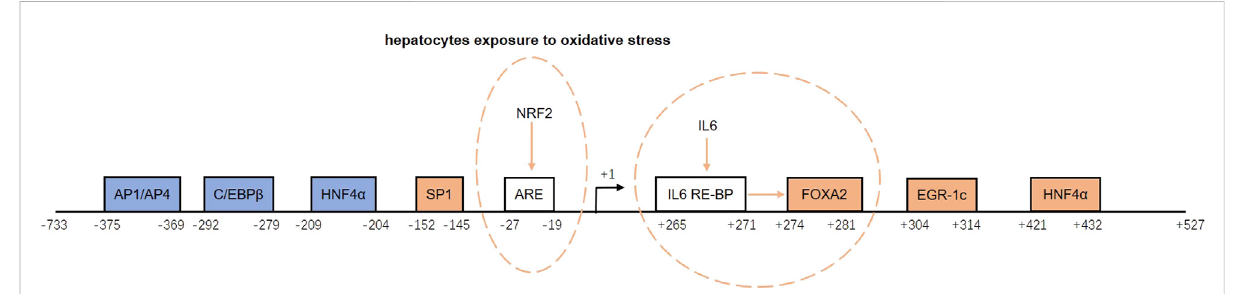
FIGURE 2 Structure and regulation of the augmenter of liver regeneration (ALR) gene promoter. The blue boxes represent repressors, and the orange boxesareinducers.AREandIL-6RE-BPareinducingresponseelements.NRF2bindstoAREandinducesALRgeneexpressionwhenhepatocytesare exposed to oxidative stress. When IL-6 RE-BP is activated by IL-6, it increases the activating effect of FOXA2. AP1/AP4, activator protein 1/activator protein 4; C/EBP β , CCAAT/enhancer binding protein-beta; HNF4 α , hepatocyte nuclear factor 4 alpha; SP1, speci fi c protein 1; ARE, antioxidant responseelement;NRF2,nuclearfactorerythroid2-relatedfactor2;IL-6,interleukin-6;IL-6-RE-BP,IL-6responseelementbindingprotein;FOXA2, forkhead box A2; Egr-1, early growth response protein